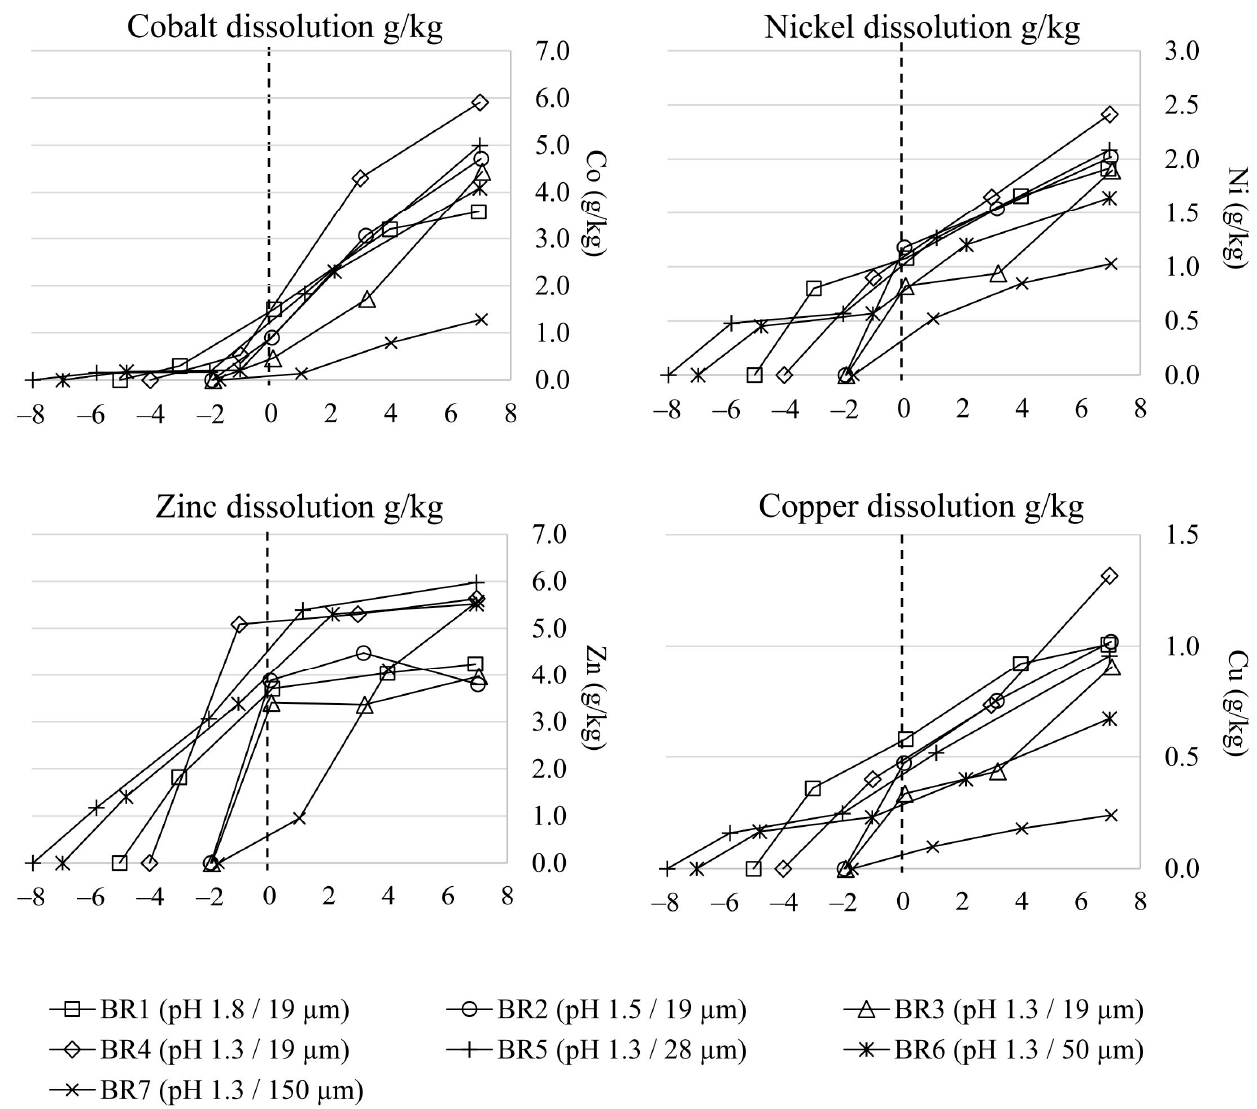
Figure 3. Metal dissolutions expressed as metals dissolved (grams) per sulfide concentrate added (kg). The horizontal axis represents leaching days (negative days were the ramp-up; positive days were the actual operation).